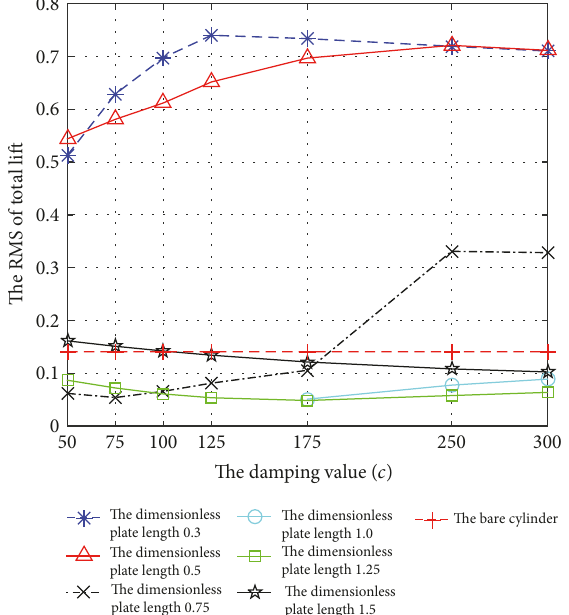
Figure 14: The variation of the RMS of total lift coefficient with the changing of the damping value.